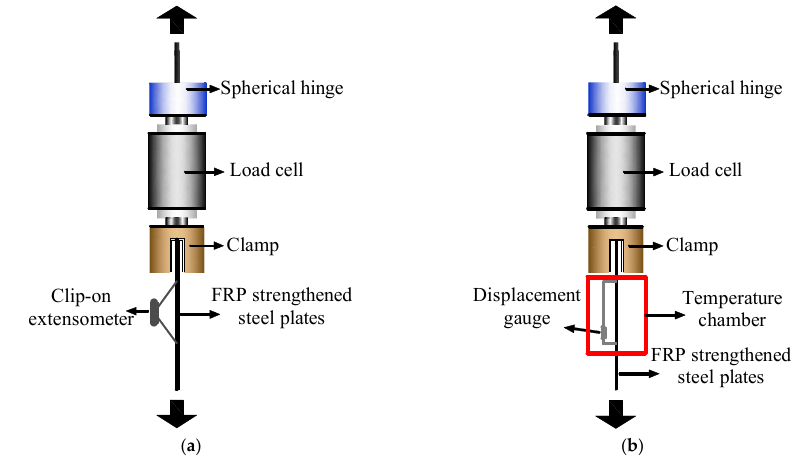
Figure 2. Schematic view of test setup: ( a ) test setup for ambient temperature; and ( b ) test setup for elevated temperatures.